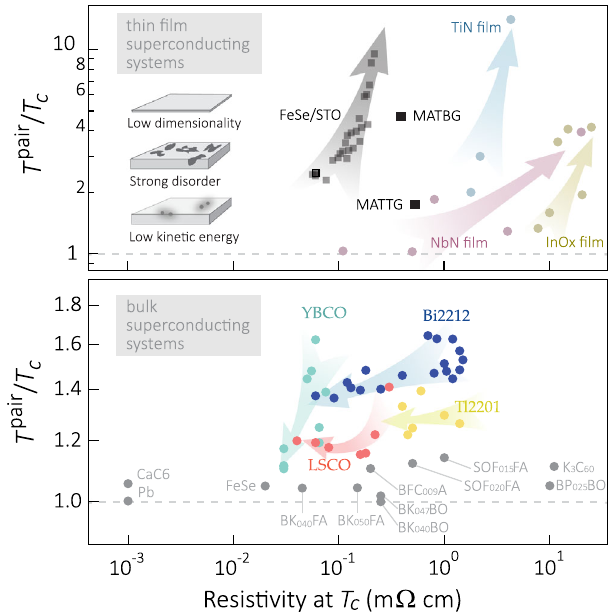
FIG. 1. Thermal superconducting fluctuation effect in conven- tional and unconventional superconductors. Superconducting gap opening temperature T divided by zero resistance temperature pair T tallied according to the resistivity right above T c thin film superconductors and (bottom) bulk superconductors. Arrows denote increasing disorder in thin film systems and increasing hole doping in the cuprates. Except for TBG and TTG systems, T is exclusively determined from heat capacity or pair single-particle spectra [16]. MATBG (MATTG), magic angle twisted bilayer (trilayer) graphene; FeSe = STO, monolayer FeSe on Nb ∶ SrTiO 3 ; BKFA, Ba 1 − K Fe 2 As 2 ; BFCA, Ba ð Fe 1 − x x